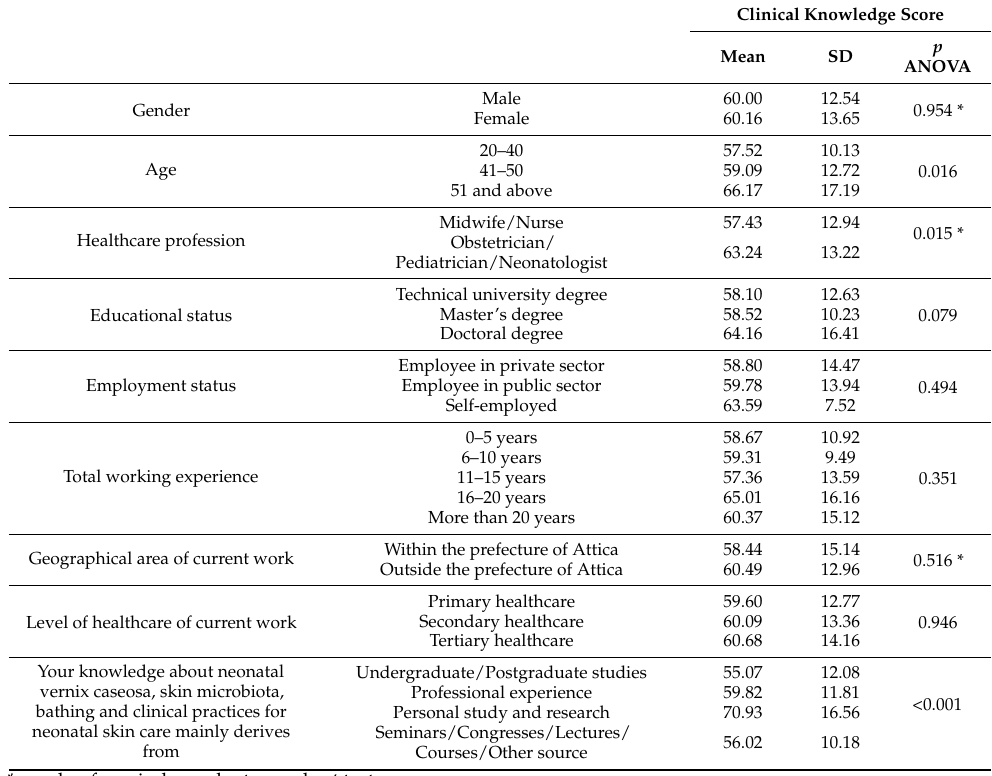
Table 5. Associations among participants’ clinical knowledge score and demographic and occupa- tional